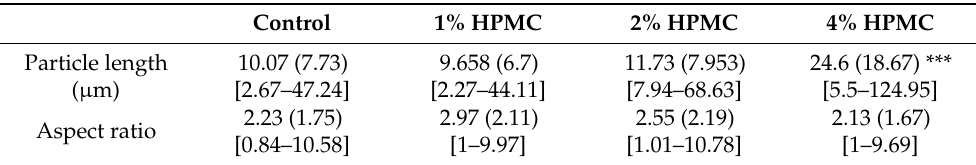
Table 2. Particle length and aspect ratio of the particle in a collapsed process.